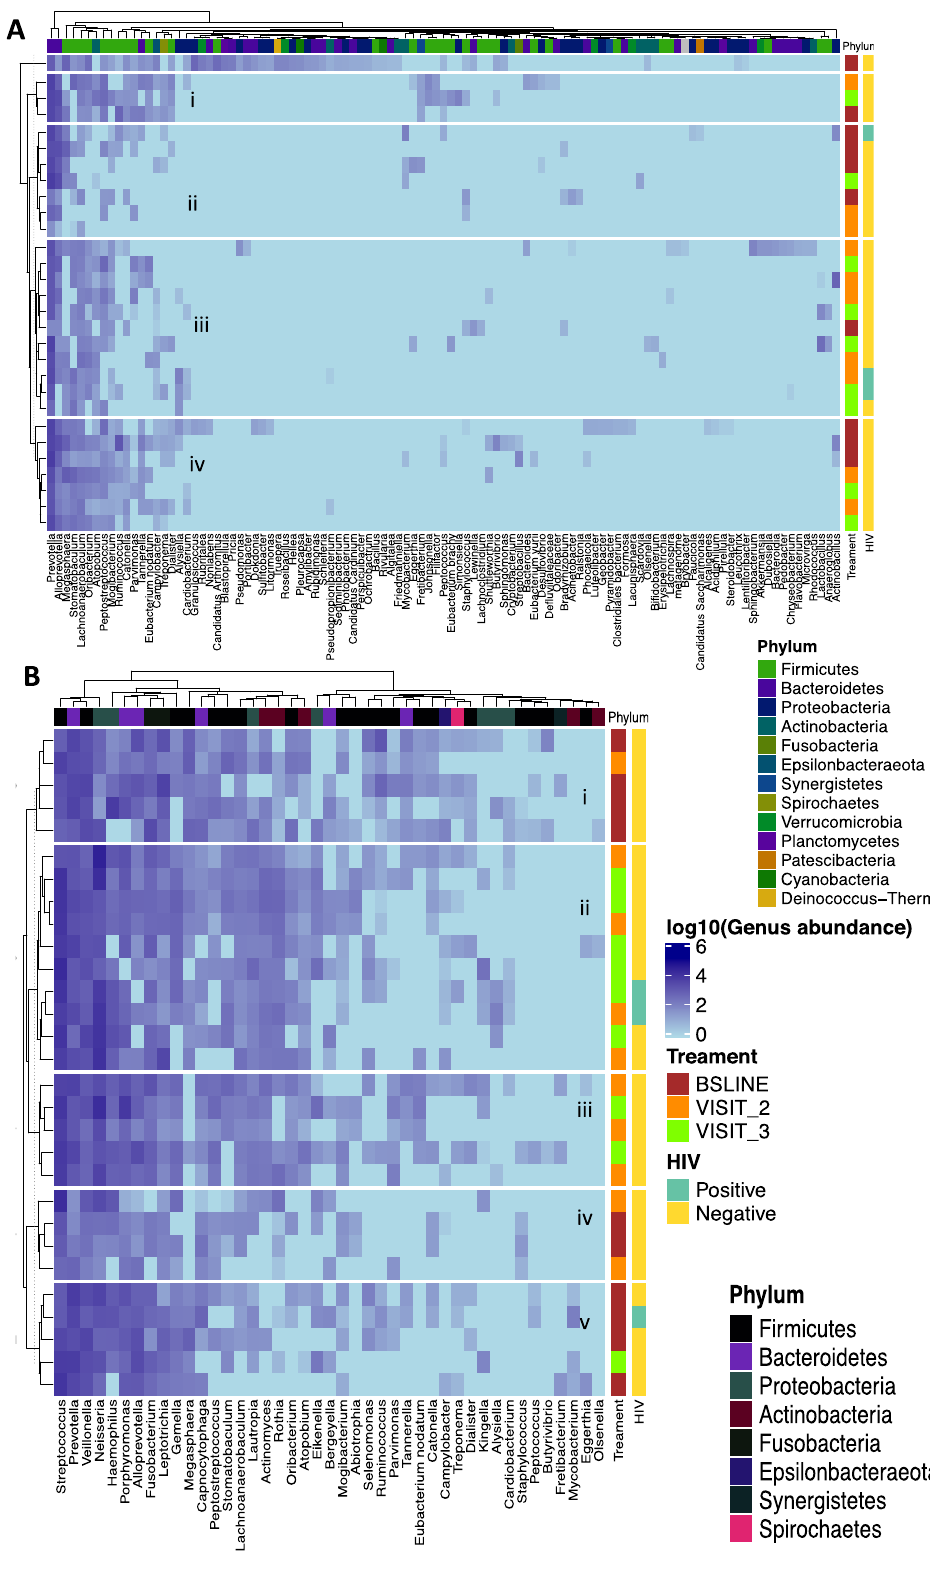
Figure 5. Hierarchical clustering of the normal flora ( A ) and core ( B ) at genera level. This clustering allows us to identify groups (i)–(v) that correspond to clinical covariates i.e., treatment response follow-up time and HIV status. This figure is based on dataset C of Fig.